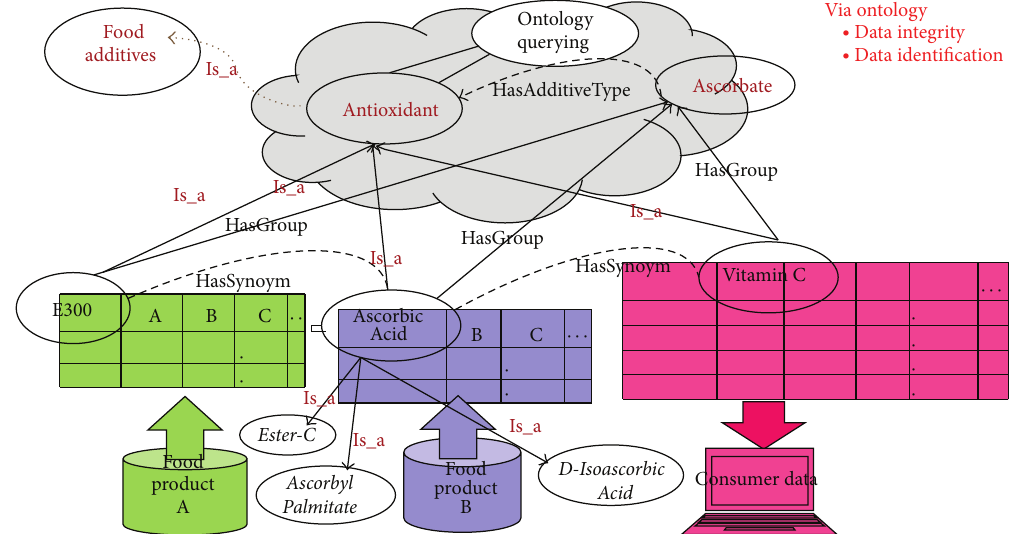
Figure 3: Semantic enhancement of the concept matching engine